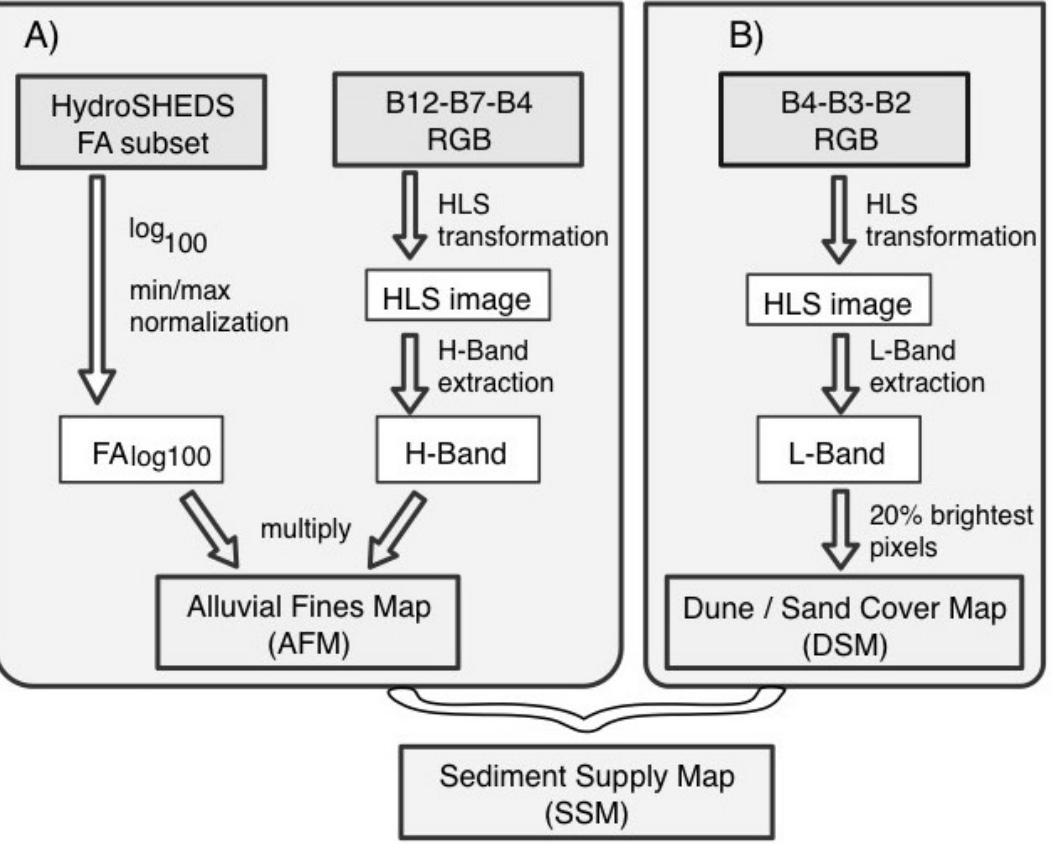
Figure 2. ( A ) Extraction of Alluvial Fines Map (AFM) from HydroSHEDS flow accumulation dataset and Sentinel-2 bands B12, B7, and B4; and ( B ) derivation of Dune/Sand Cover Map (DSM) from Sentinel-2 bands B4, B3 and B2 and their integration into a Sediment Supply Map